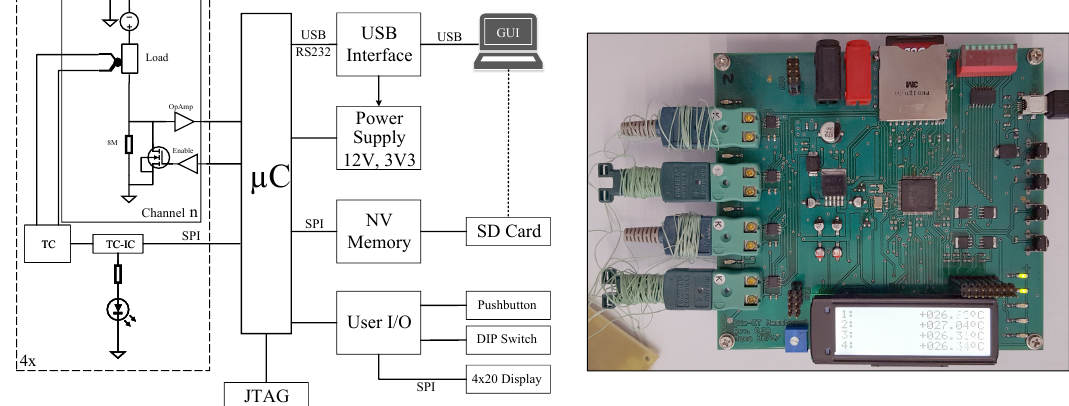
Figure 9. Left: Measurement circuit for test components with load control and temperature measurement. Right: Fully assembled measurement